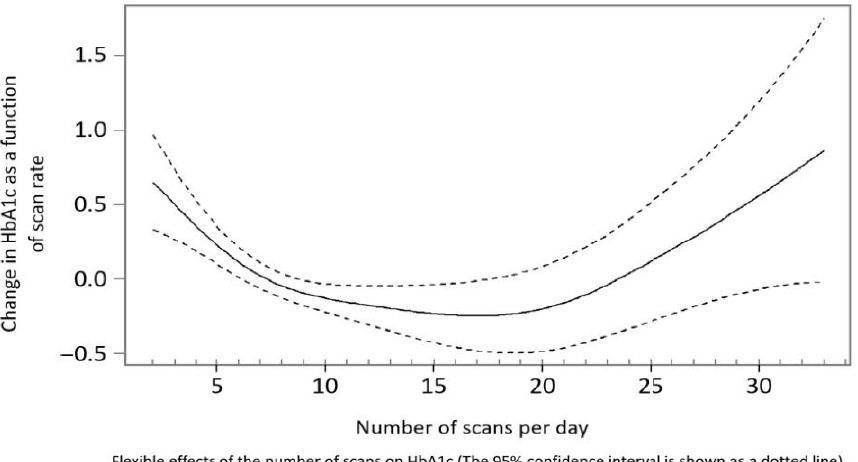
Figure 1. Relationship between number of daily scans with the FreeStyle Libre system and